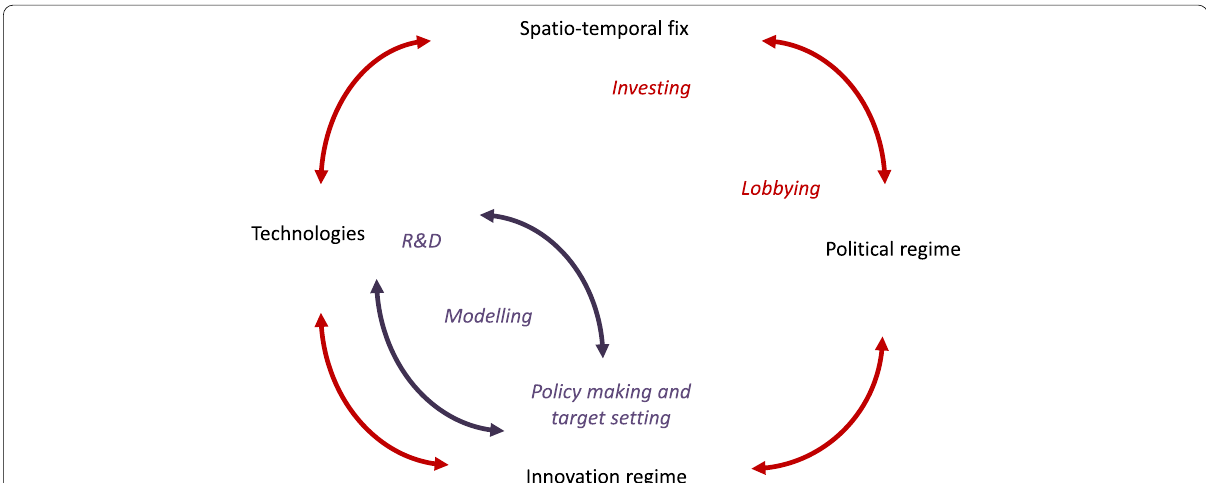
Fig. 3 Fast and slow co-evolutionary dynamics of the cultural political economy of mitigation deterrence. Note: The quick, small, co-evolutionary dynamic is indicated in purple, and the slow, large loop in red. Related practices indicated in